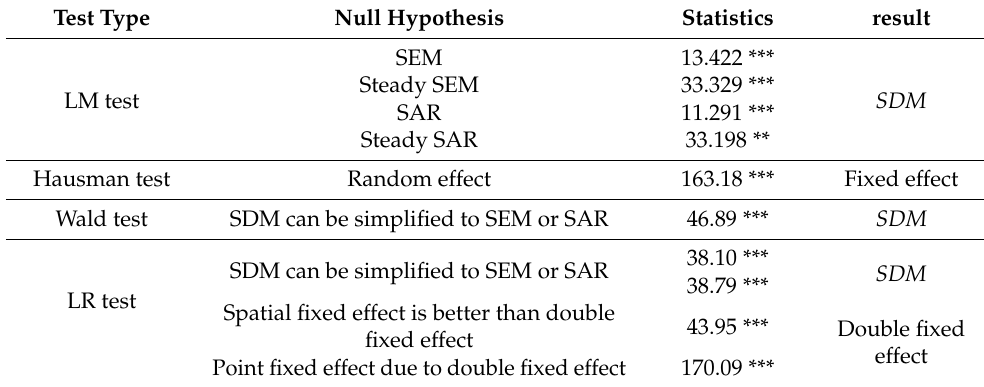
Table 5. Model selection related test